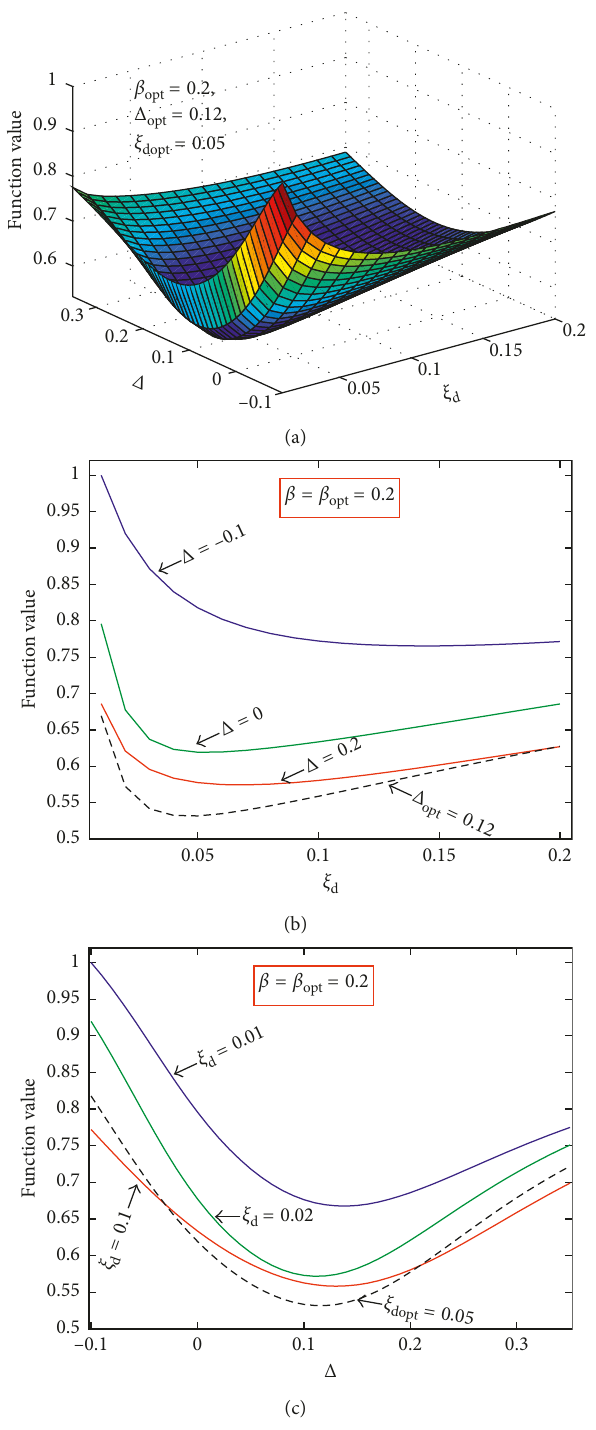
Figure 5: Relationship between objective function and different frequency deviation and damping ratio values under conditions of optimal coverage rate. Relationship between objective function and . different values of (a) and ξ d , (b) ξ d , and (c) Δ Δ